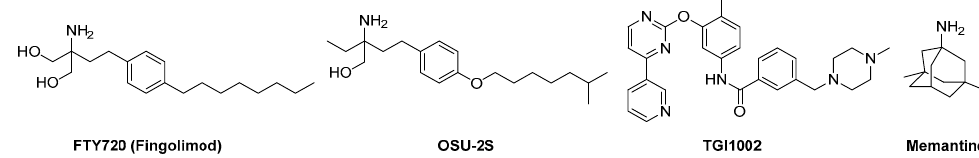
Figure 5. Chemical structures of PP2A-activating drugs (PADs) that act through inhibiting SET.